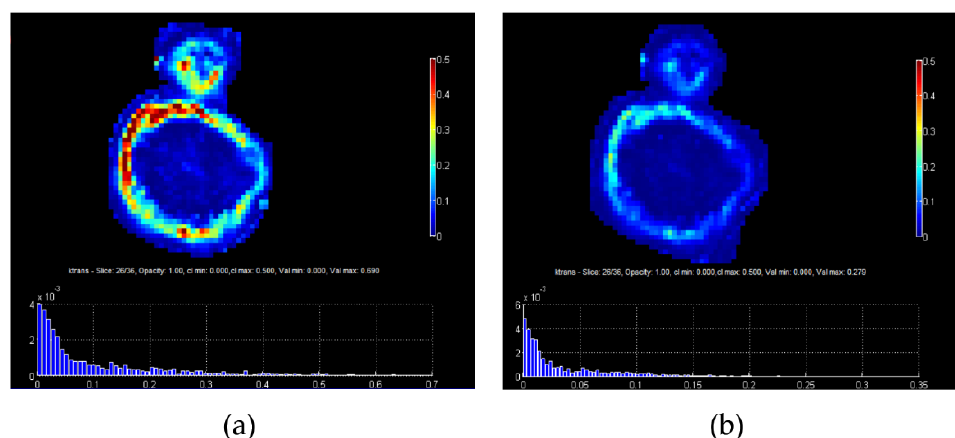
Figure 3. ( a ) ktrans map of a tumor from PK analysis using AIF measured directly from the MR image, while for the conversion from signal to CA concentration the multiple flip angles method (mFAs) was used, ( b ) ktrans map of the same tumor using a population based AIF from Fritz and Hansen.